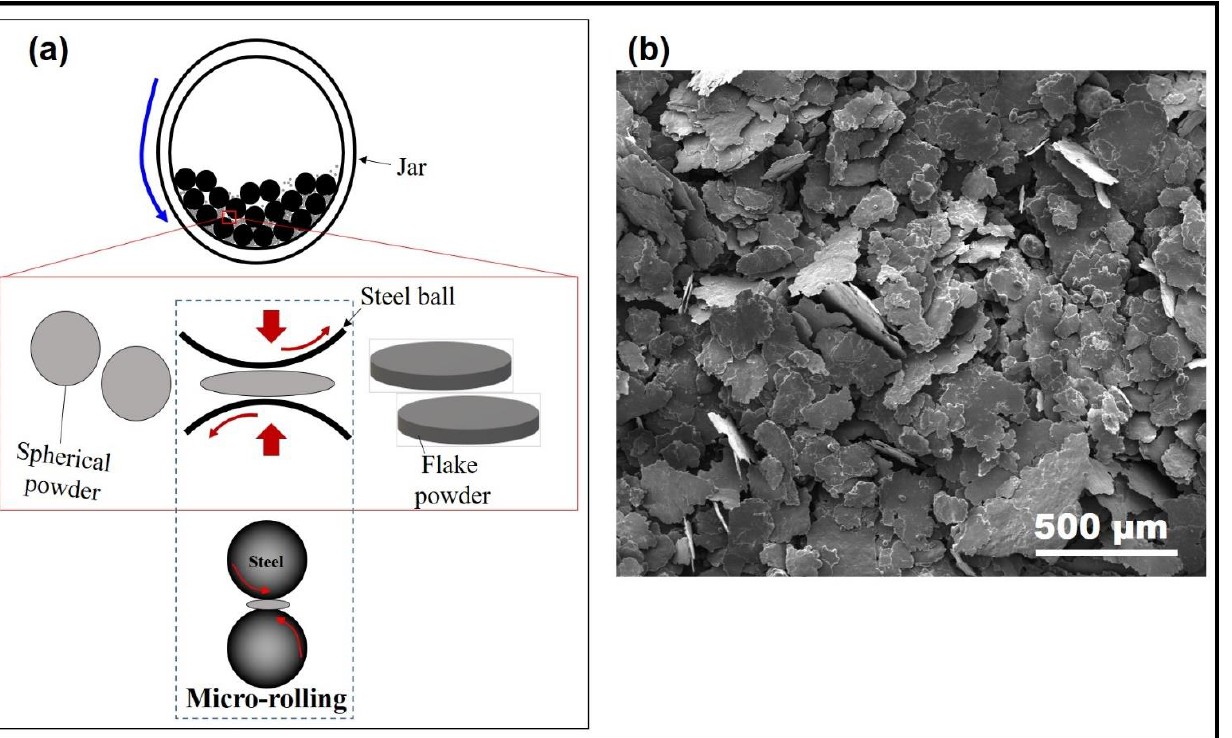
Figure 1. ( a ) Schematic of micro-rolling process, ( b ) SEM images of CNT/Al flakes under C-FPM route.